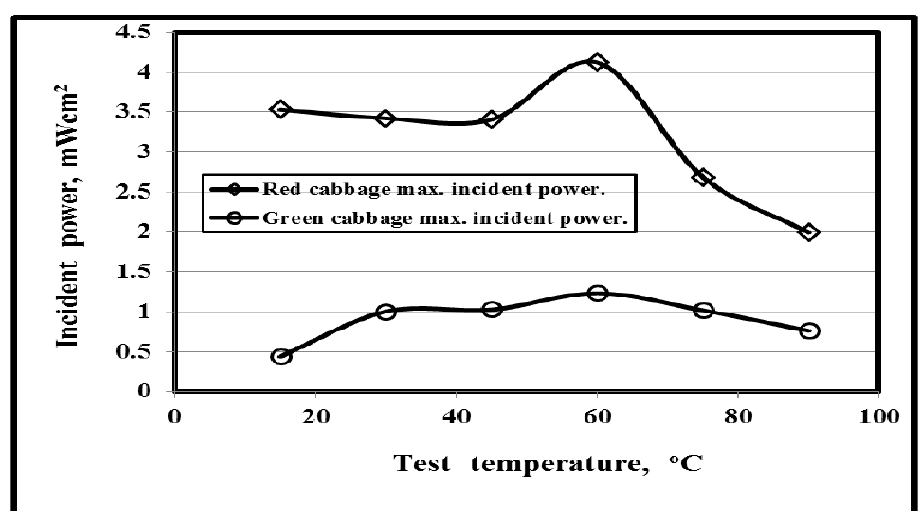
Figure 14. Incident power/temp. relation for RC and GC.